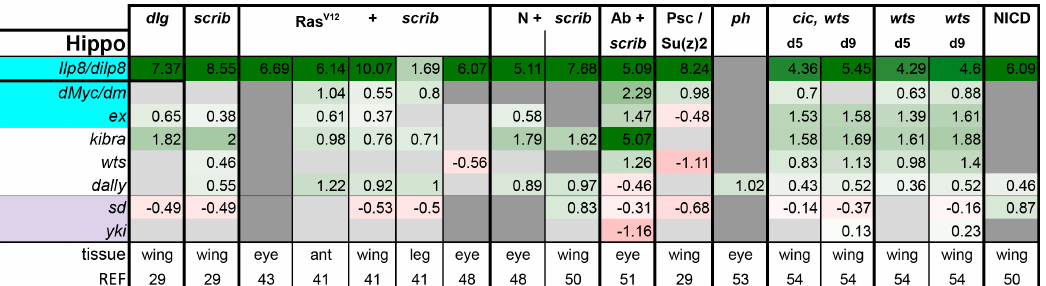
Figure 4. Yorkie activation contributes to tumorigenesis in models with polarity loss. Light purple highlights the nuclear factors of the pathway. Target genes that are known to also be regulated by other pathways are highlighted in cyan. Gene expression is displayed in log2FC. Color coding corresponds to a heatmap with a scale from − 5 (dark red) to 5 (dark green). Light grey cells represent non-significant changes with p ≥ 0.05. Dark grey: the gene was not found in the dataset. Abbreviations: Insulin like peptide 8, Ilp8; diminutive, dm; expanded, ex; warts, wts; division abnormally delayed, dally; scalloped, sd; yorkie, yki.